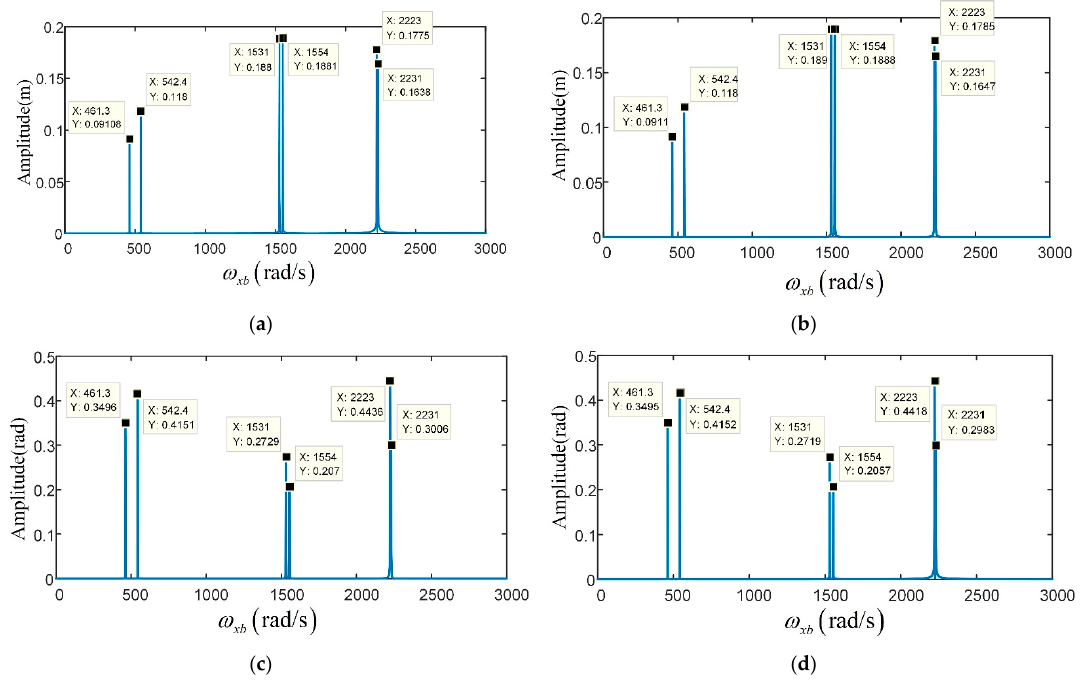
Figure 8. Responses of the counter-rotating dual-rotor system at the disk 1 under harmonic base translations: ( a ) x d 1 ; ( b ) z d 1 ; ( c ) θ d 1 ; ( d ) ψ d 1